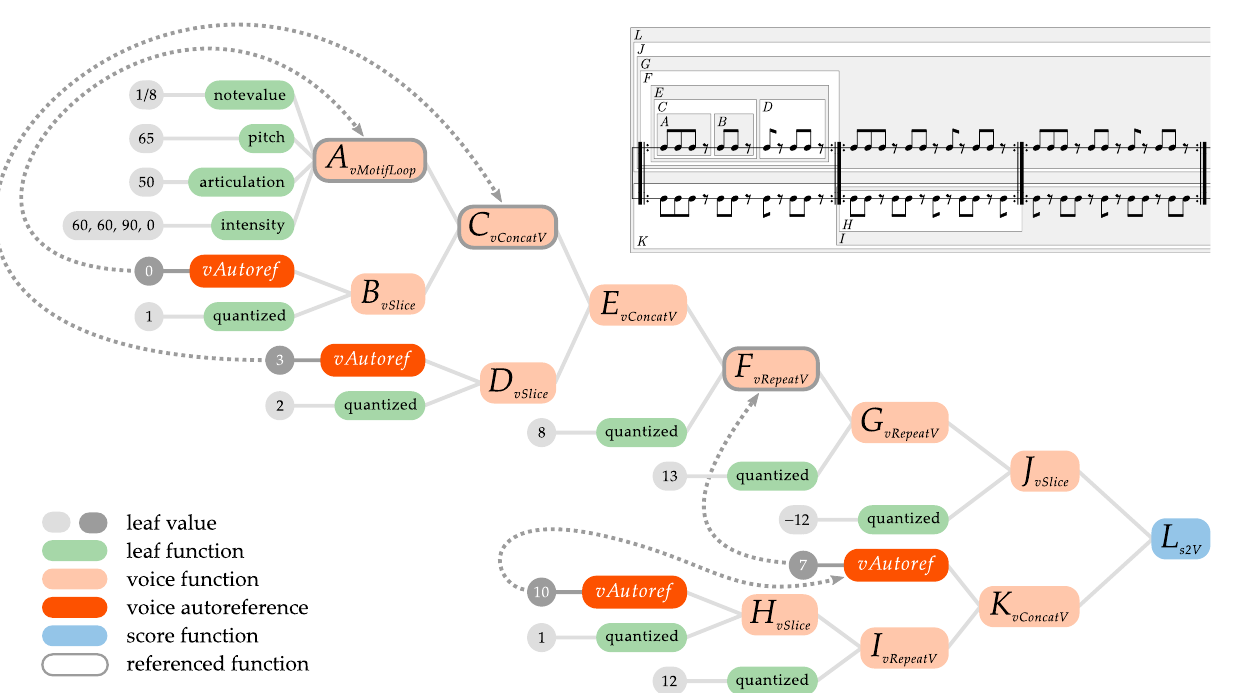
Figure 13. Functional tree of Clapping Music decoded genotype, along with the patterns in the score. A step-by-step slideshow version of this graph with additional comments can be found in the Supplementary Materials linked at the end of the